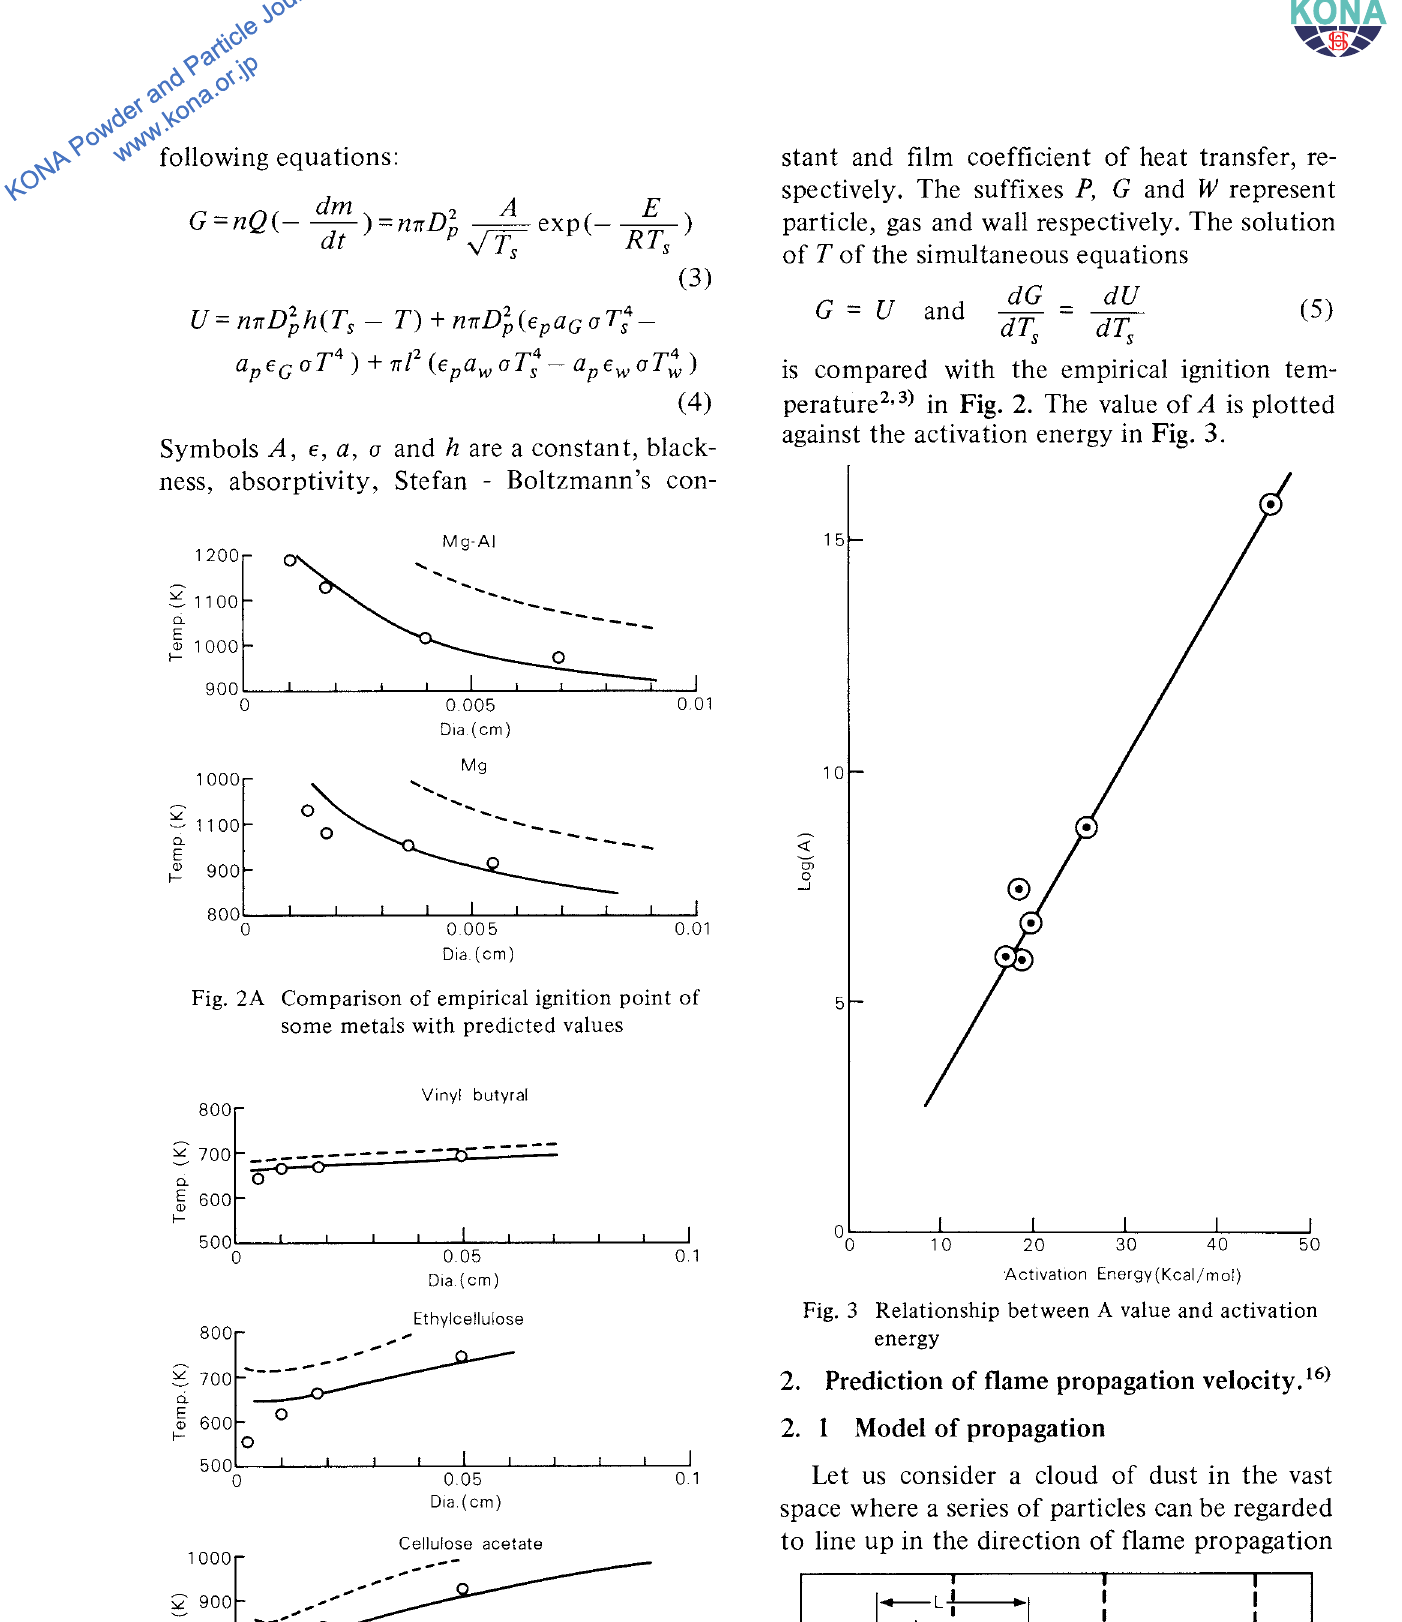
Fig. 2B Comparison of empirical ignition point of some plastics with predicted values